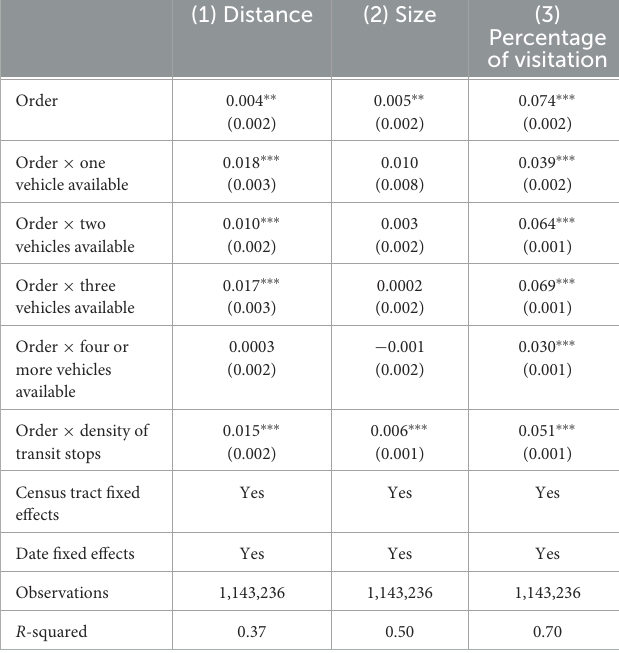
TABLE 4 Mobility disparities before and after stay-at-home